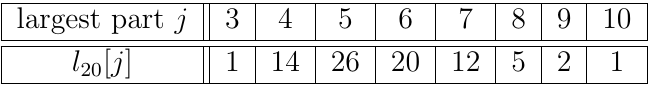
[ j ]) connected graphical 20